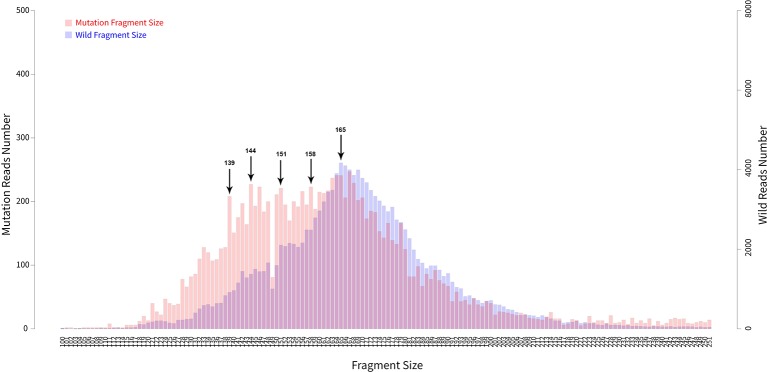
Fragment length distributions of cfDNAs from 105 cancer patient blood samples.